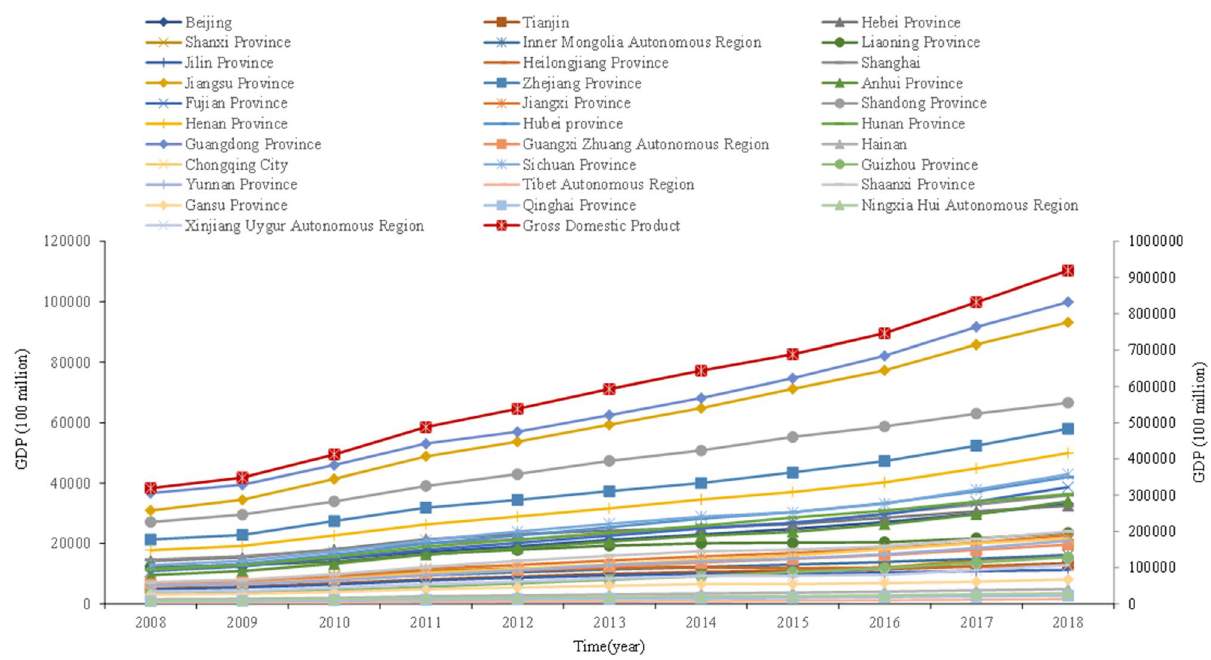
Figure 2. Annual GDP Changes of China’s Provinces and Municipalities from 2008 to